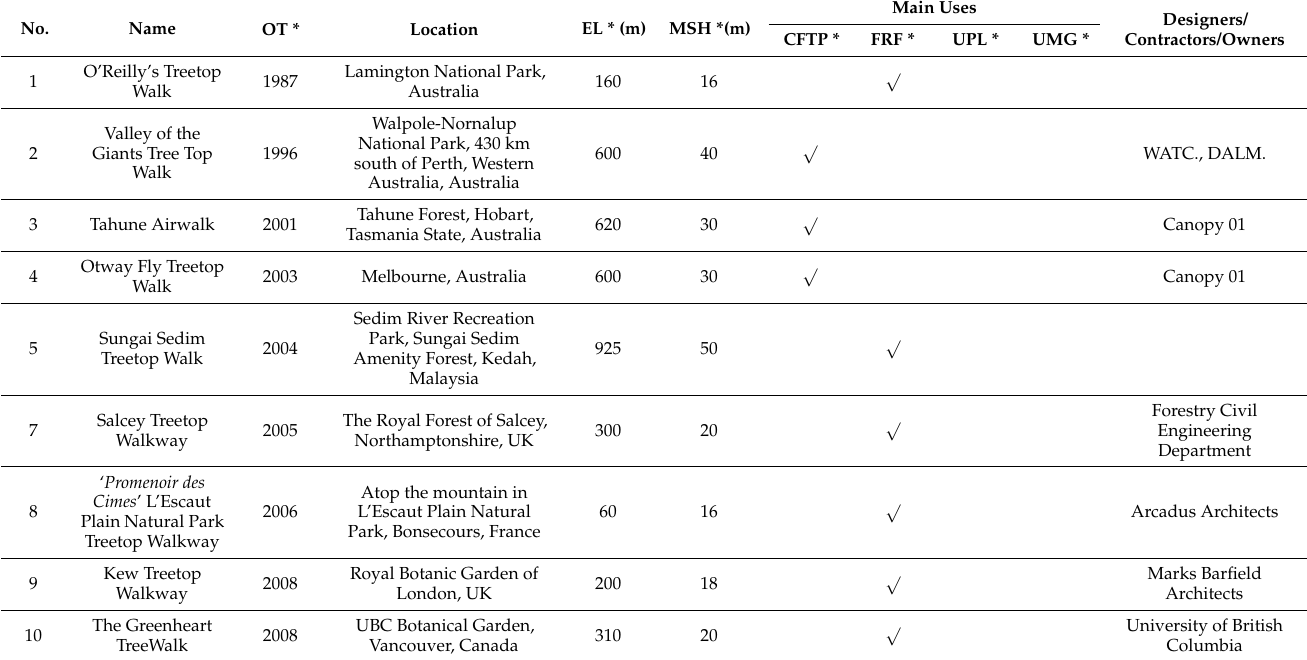
Table A1. Basic information about global treetop